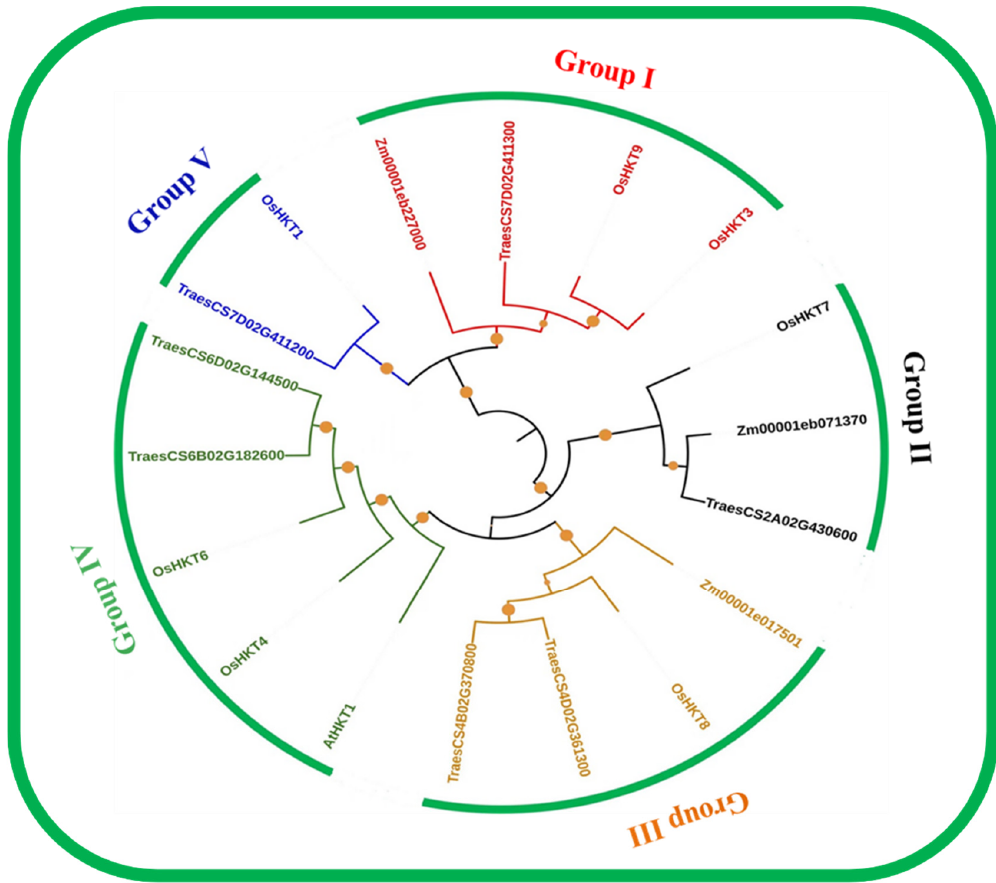
Figure 1. HKT protein phylogeny in three plants: T. aestivum, Zea maize, and O. sativa . MEGA 7 was used for the phylogenetic tree using the following parameters: Bootstrap D 1000 replicates, maximum likelihood method, and Poisson correction. All group members were divided into five groups, each represented by an assorted color. Different labels were used to identify members of various species.